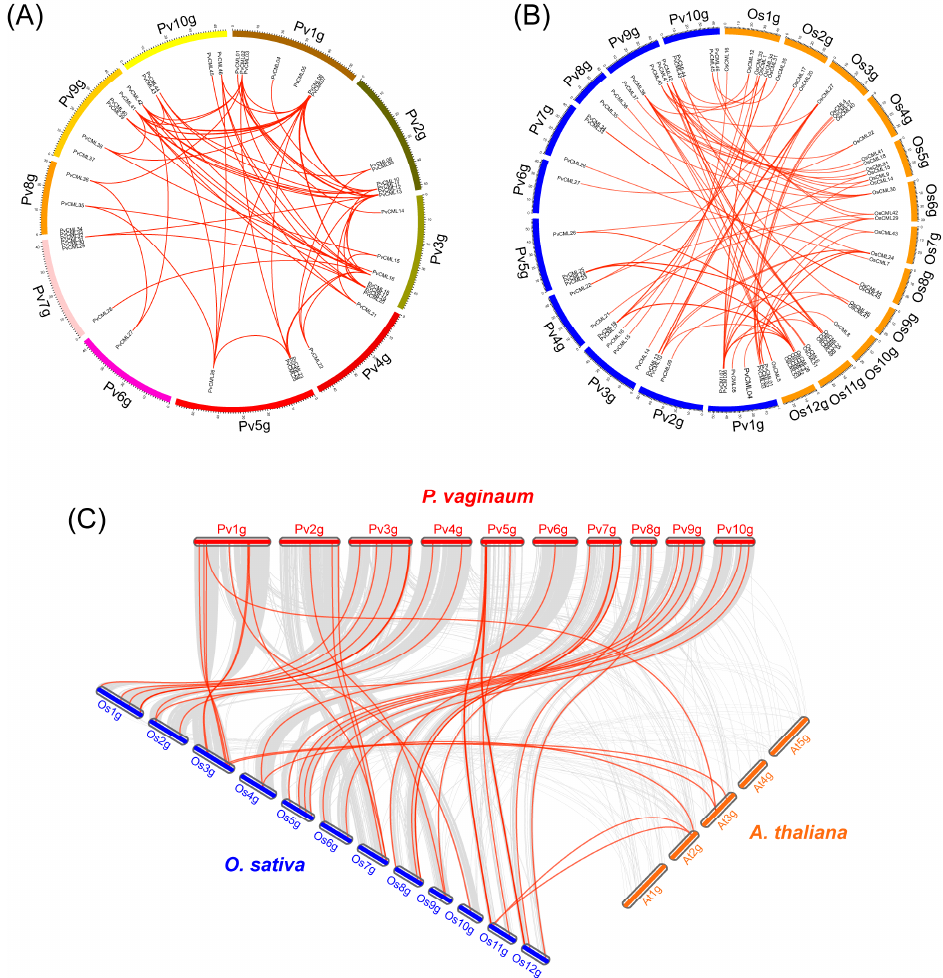
Figure 3. Chromosomal distribution and synteny analysis in the genomes of P. vaginatum , Oryza sativa , and A. thaliana . ( A ) Paralogous genes of PvCMLs in P. vaginatum . ( B ) Orthologous CML genes between P. vaginatum and rice. ( C ) Orthologous CML genes between P. vaginatum and A. thaliana and between P. vaginatum and rice. Red lines indicate orthologous gene pairs.